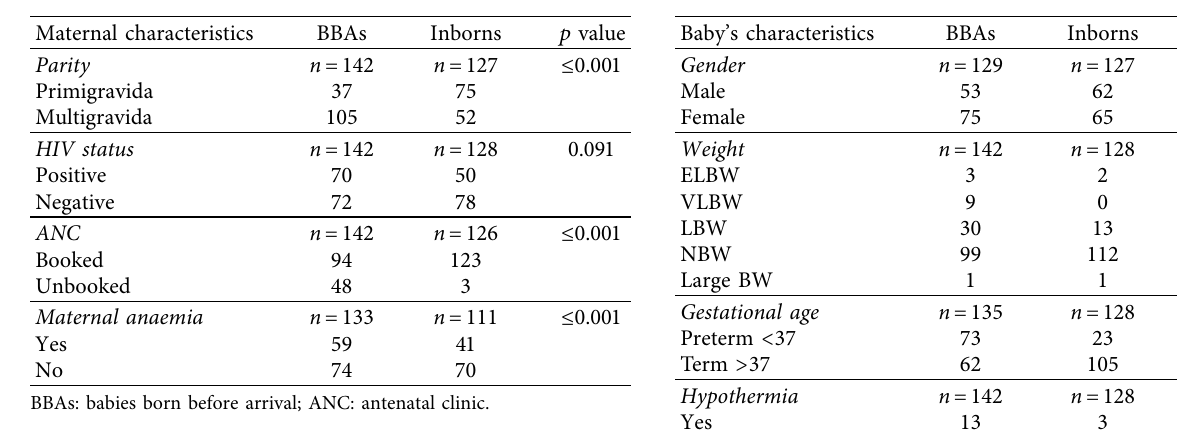
Table 2: Characteristics of babies.